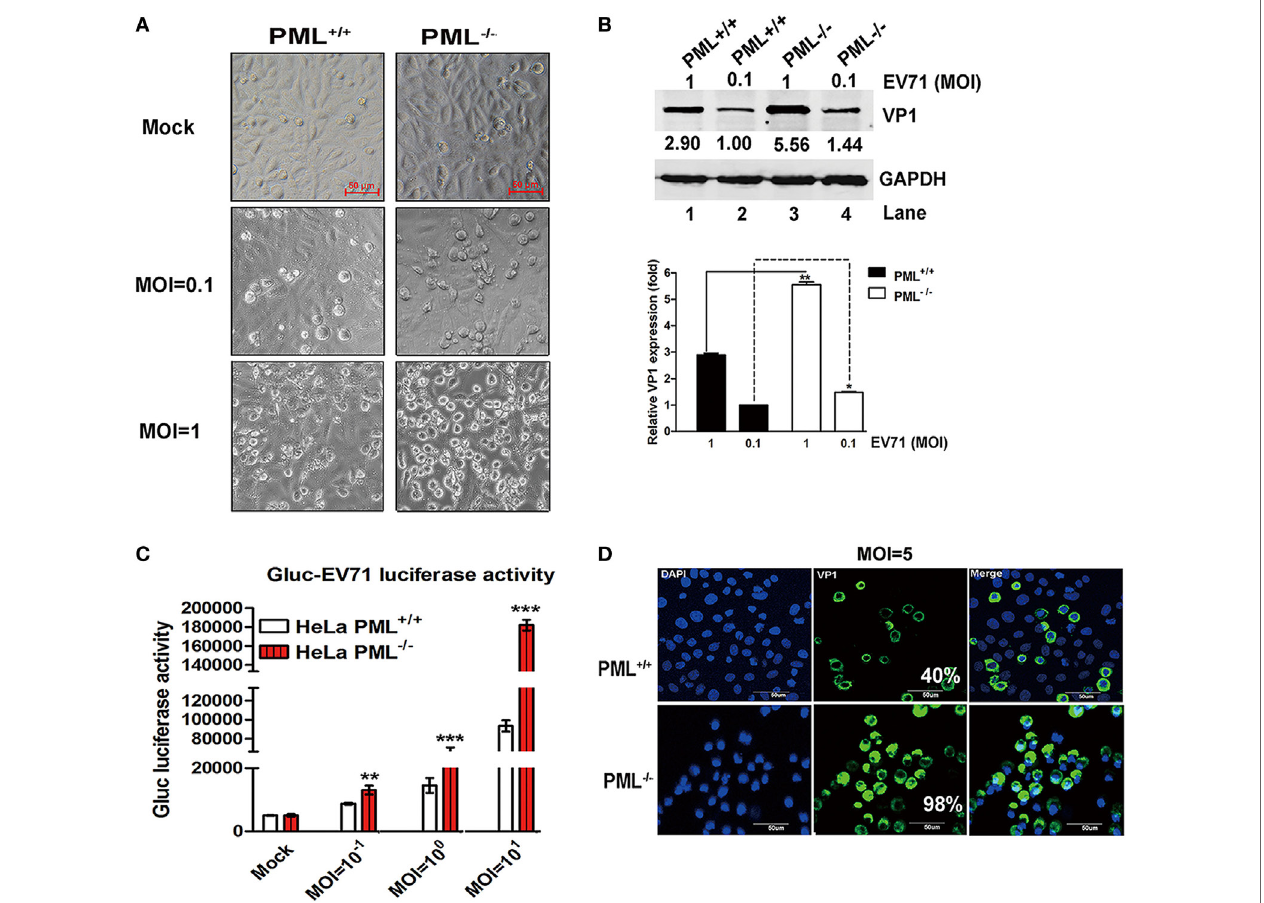
FigUre 2 | Comparison of enterovirus 71 (EV71) infection in PML − / − and PML + / + cells. (a) PML + / + and PML − / − cells grown in 12-well plates were infected with Gluc-EV71 at various multiplicity of infections (MOIs) (mock-infected in the top panel, and MOI = 0.1 or 1 in the middle or lower panels, respectively) for 24 h. The EV71-induced CPE in the PML + / + and PML − / − cells was examined using microscopy (scale bar: 50 µm). A representative experiment of three experiments is shown. (B) The relative VP1 expression in PML + / + or PML − / − cells infected with Gluc-EV71 (MOI = 0.1 or 1) for 24 h is shown. Densitometry was performed, the values from three independent experiments were averaged, and the data are expressed as the fold change in VP1 expression in the PML − / − cells infected at an MOI of 0.1 or 1 or PML + / + cells infected at an MOI of 1 compared with that in the PML + / + cells infected with EV71 at an MOI = 0.1 (Lane 1 is set as 1.00). The VP1 expression in PML + / + cells infected with EV71 at an MOI of 0.1 is assigned a value of 1.00 (** p < 0.01). (c) The PML + / + and PML − / − cells were infected with Gluc-EV71 at various MOIs for 24 h, and the cell culture supernatants were measured by performing a luciferase activity assay (Gluc-EV71 infection). The values are the means of three experiments and are presented relative to the level in the mock infection of the PML + / + (white) and PML − / − (red) cells. The data are presented as the mean ± SEM ( n = 3, ** p < 0.01, *** p < 0.001). (D) The PML + / + and PML − / − cells were infected with Gluc-EV71 (MOI = 5) for 24 h. The infected cells were identified by staining with an anti-VP1 antibody (green), and DAPI (blue) was used to stain the nuclei. The quantification represented the average of four different fields. Percentage (%) indicates the percentage of infected cells among the total cells. The images were acquired under an Olympus FluoView FV10i confocal microscope (Tokyo, Japan) (scale bar: 50